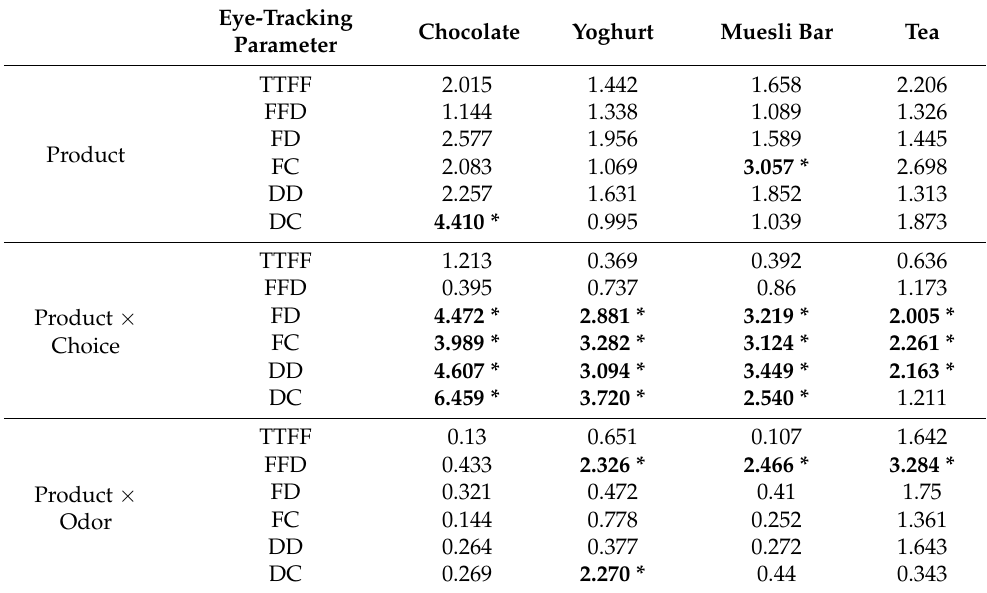
Table 3. Results of the repeated measures ANOVA (RMANOVA). Factor choice is not stated due to no significant effects observed in RMANOVA.